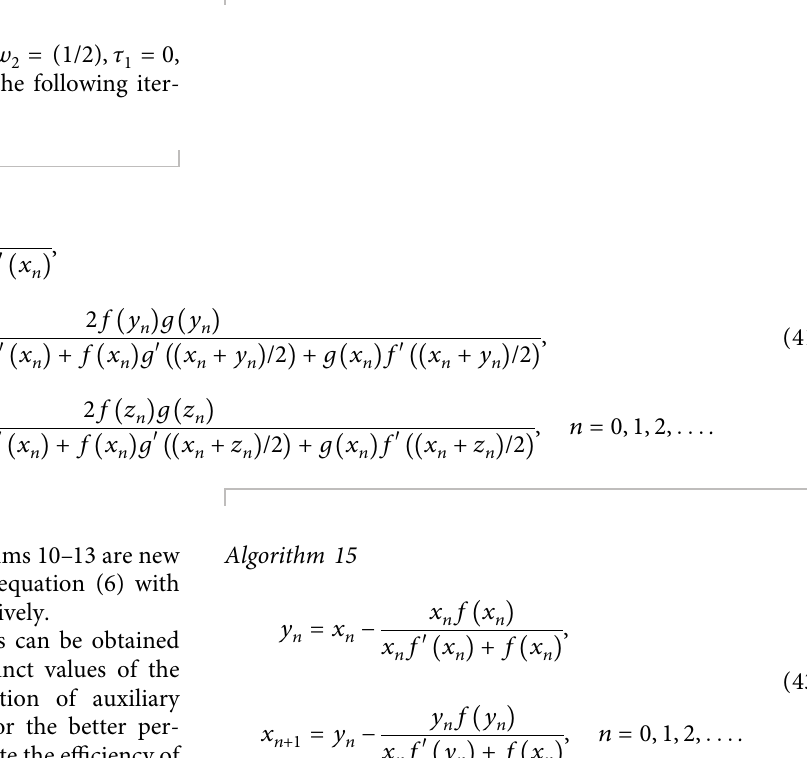
Algorithm 13. Taking p � 2 , w